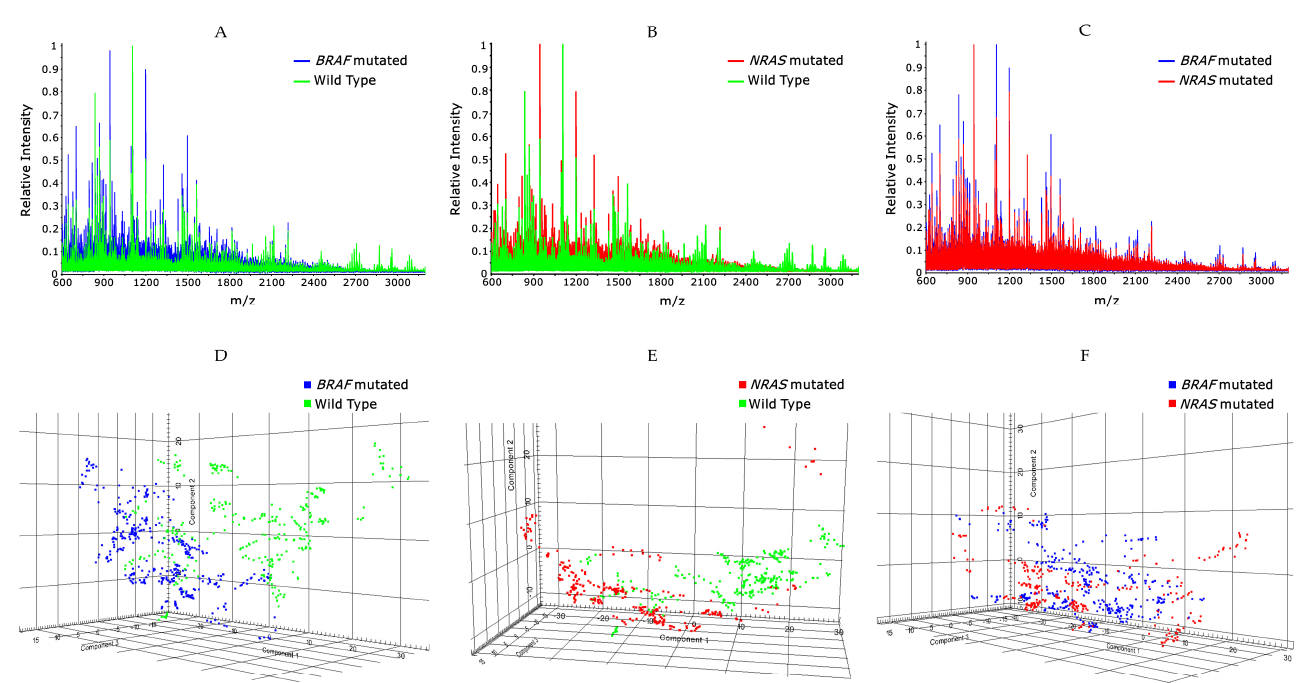
Figure 1. Comparison peptide profile between the average spectrum from BRAF (v-raf murine sarcoma viral oncogene homolog B1) mutated (blue) and BRAF wildtype (green) melanoma ( A ), NRAS (neuroblastoma RAS viral oncogene homolog) mutated (red) and NRAS wildtype (green) ( B ), and BRAF (blue) and NRAS (red) mutated melanoma ( C ). BRAF and NRAS mutated spectra show different profiles when individually compared to the WT tissues ( A , B ), while their profiles show similarity when compared with each other ( C ). Wildtype spectra include both BRAF and NRAS wildtype patients. Three-dimensional plot of the first three components, resulting from the principal component analysis (PCA), showing separation between BRAF mutated (blue) and BRAF wildtype (green) ( D ), NRAS mutated (red) and NRAS wildtype (green) ( E ) spectra. PCA of BRAF (blue) and NRAS (red) mutated samples show a subtle separation of the two types of spectra ( F ). Each pixel in the PCA corresponds to a spectrum.